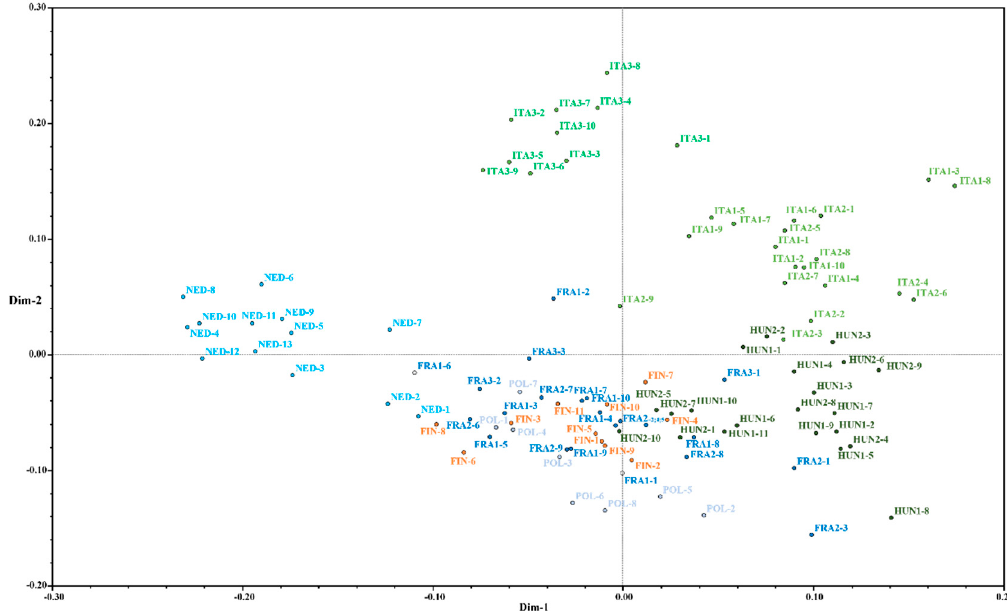
Figure 2. Principal component analysis (PCoA) displaying centroids of individual plants across all Cannabis varieties plotted according to the first two dimensions based on the 20 selected SSR marker loci.